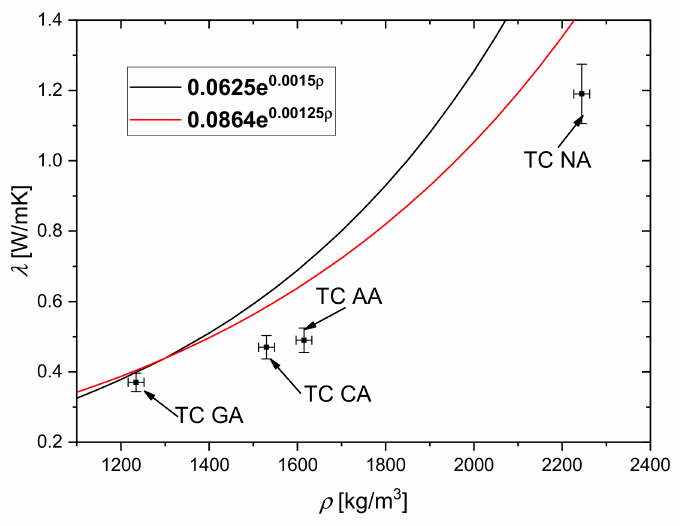
Figure 9. Relationship between thermal conductivity of the specimens. For comparison, predictions of Equations (4) and (5) are also